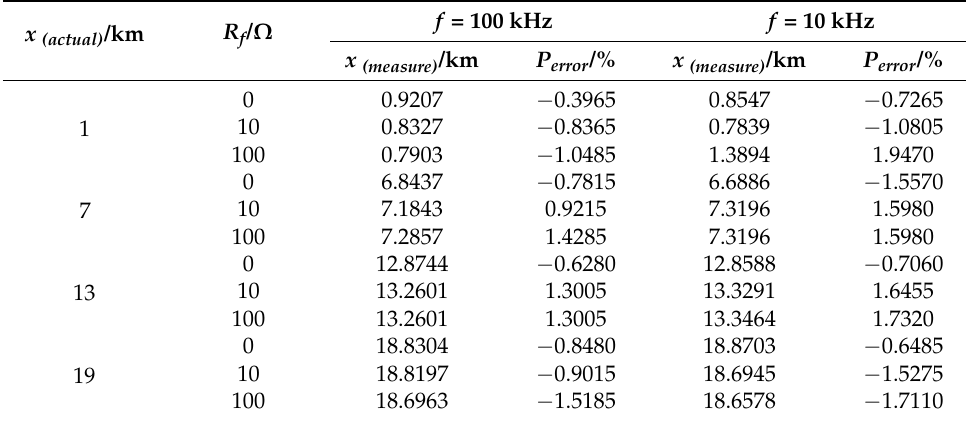
Table 3. Location results of proposed fault location method.